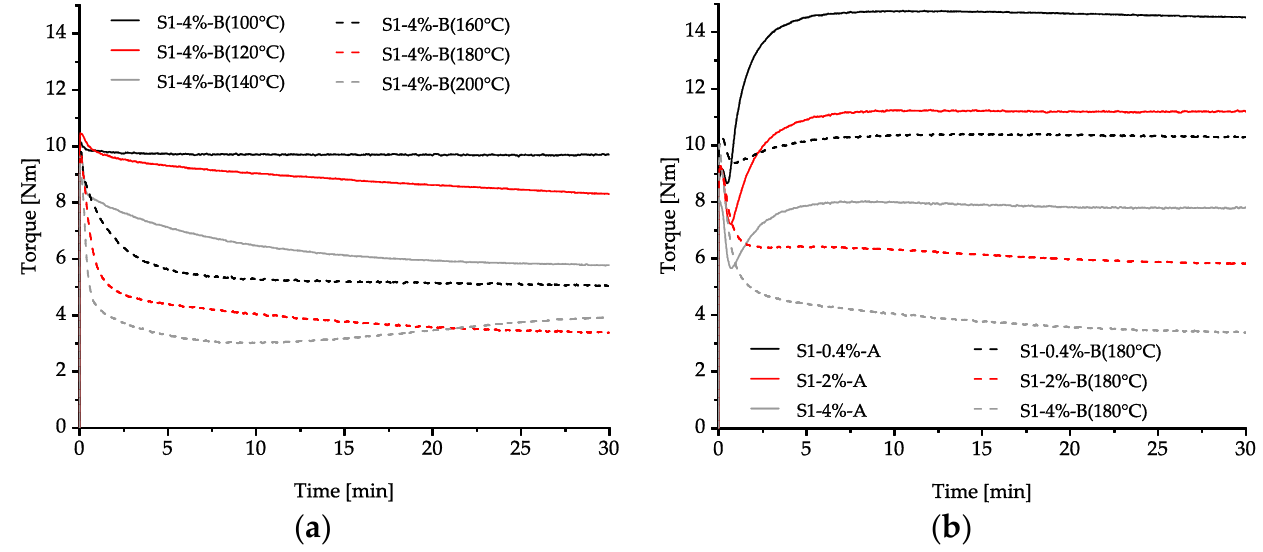
Figure 1. Rheometer curves recorded at 100 to 200 °C for S1-4%-B ( a ) and 180 °C for S1-0.4%, S1-2%, and S1-4% with (A) and without (B) a curing system ( b ).